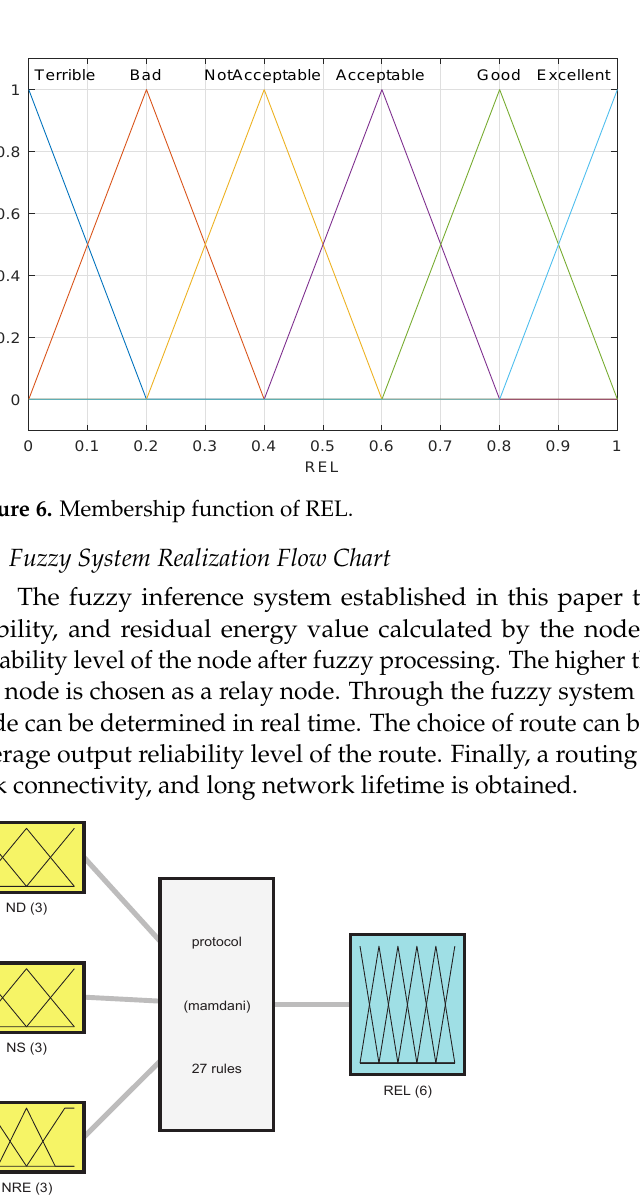
Figure 7. Flow chart of fuzzy